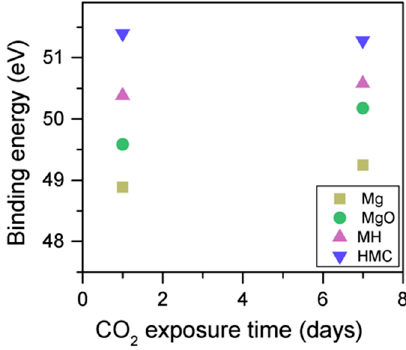
Figure 12. Mg2p BE for samples exposed to 10% CO 2 for one and seven days.